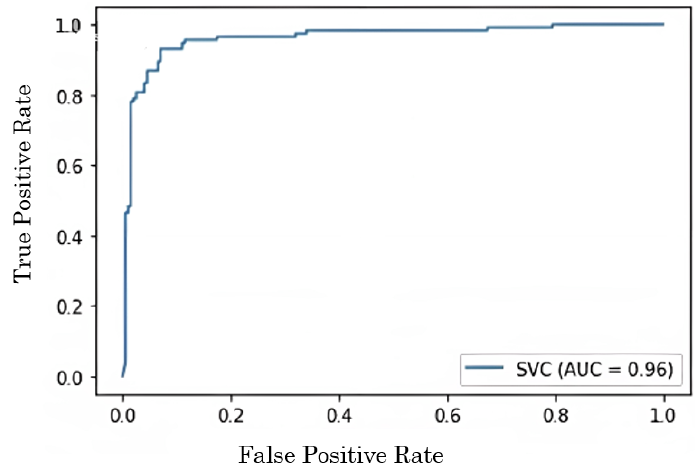
Figure 8. AUC curve to examine the performance of ensemble